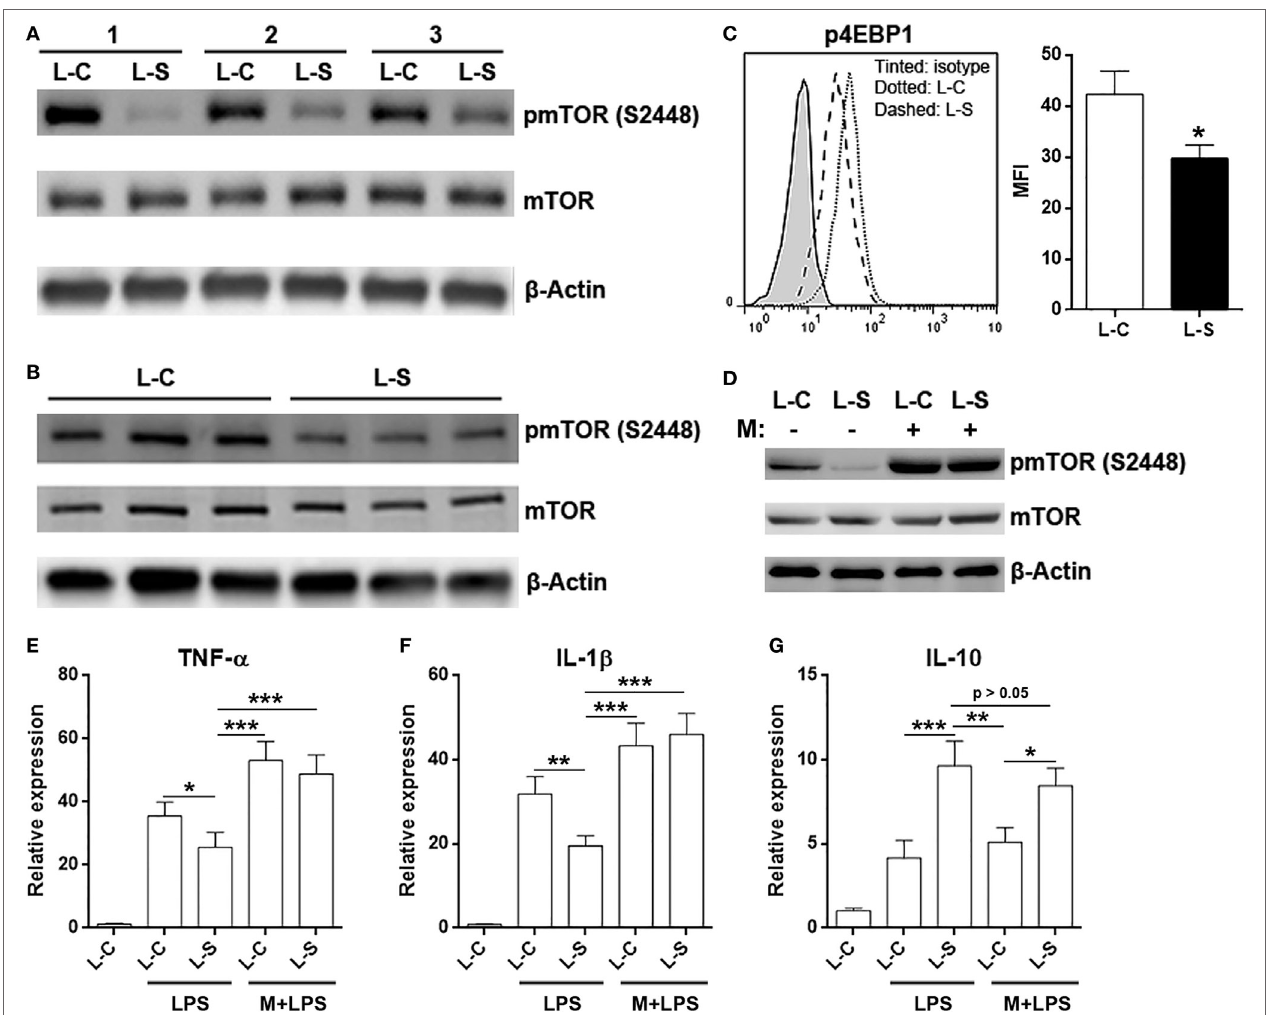
FigUre 6 | Sestrin2 inhibits mTORC1 signal pathway in M1 macrophages. (a) mTOR phosphorylation in transferred M1 macrophages. M1 macrophages were transduced with lentivirus and transferred into recipient mice as in Figure 5 . These macrophages were then sorted using flow cytometry from infarcted myocardium at day 3 after myocardial infarction (MI) for detection of mTORC1 activation status. L-C: M1 macrophages transduced with control lentivirus. L-S: M1 macrophages transduced with SESN2 lentiviral activation particles. #1 to #3 indicate three mice. (B) mTOR phosphorylation in in vitro cultured M1 macrophages after lentiviral transduction. (c) 4EBP1 phosphorylation in transferred M1 macrophages at day 3 after MI. N = 3 per group. (D) mTOR phosphorylation in in vitro cultured M1 macrophages in the presence or absence of 1-h MHY1485 treatment. L-C: M1 macrophages transduced with control lentivirus. L-S: M1 macrophages transduced with SESN2 lentiviral activation particles. This is a representative image of two independent experiments. (e–g) mRNA abundance of indicated cytokines in in vitro cultured M1 macrophages. LPS: LPS stimulation. M + LPS: MHY1485 pretreatment followed by LPS stimulation. N = 5 per group. * p < 0.05; ** p < 0.01; *** p <